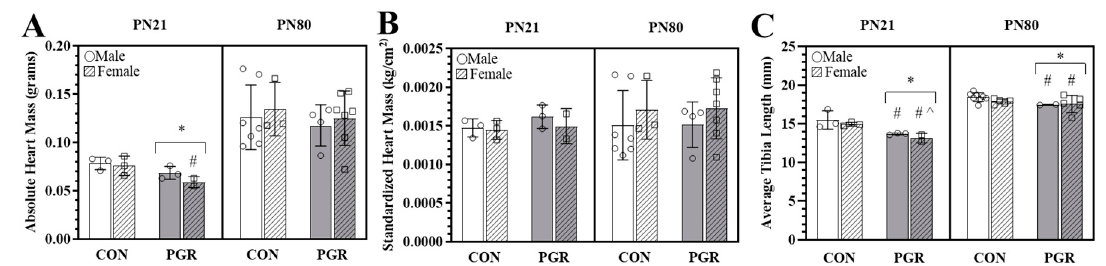
Figure 2. Effects of PGR on heart mass and tibia length: ( A ) absolute heart mass (PN21/PN80): The PN21-PGR group ( n = 6) was significantly reduced compared to CON ( n = 6); (*: p = 0.01). PGR-F